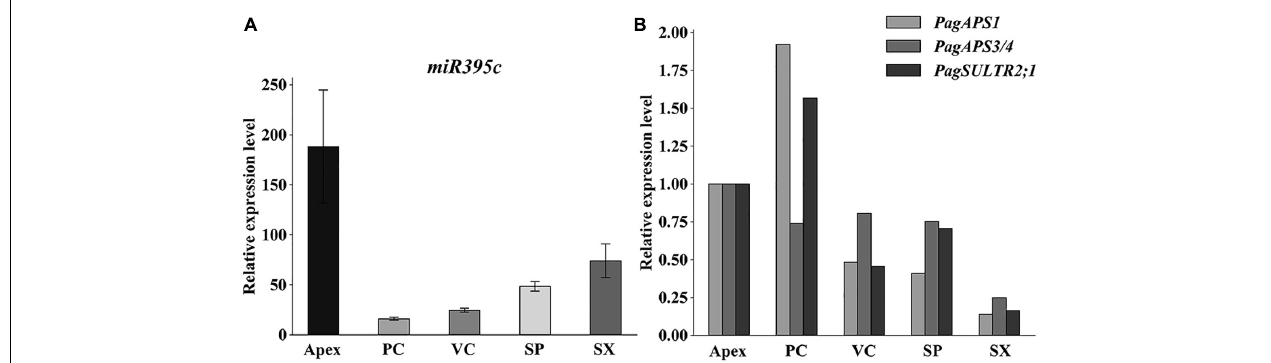
FIGURE 1 | Expression pattern of miR395c, PagATPS, and PagSULTR2;1 during vascular development in poplar. (A) qPCR analysis showing that the expression of mature miR395c in the apex and secondary xylem was higher than in the procambium, vascular cambium, and secondary phloem. (B) qPCR analysis showing that the expression of PagAPS1 , PagAPS3/4, and PagSULTR2;1 in the cambium and secondary phloem was higher than in the secondary xylem. U6 and UBQ or actin was used as internal reference genes in miRNA qPCR and mRNA qPCR analysis, respectively. Error bars represent the standard error of three independent biological replicates. PC, procambium; VC, vascular cambium; SP, secondary phloem; SX, secondary